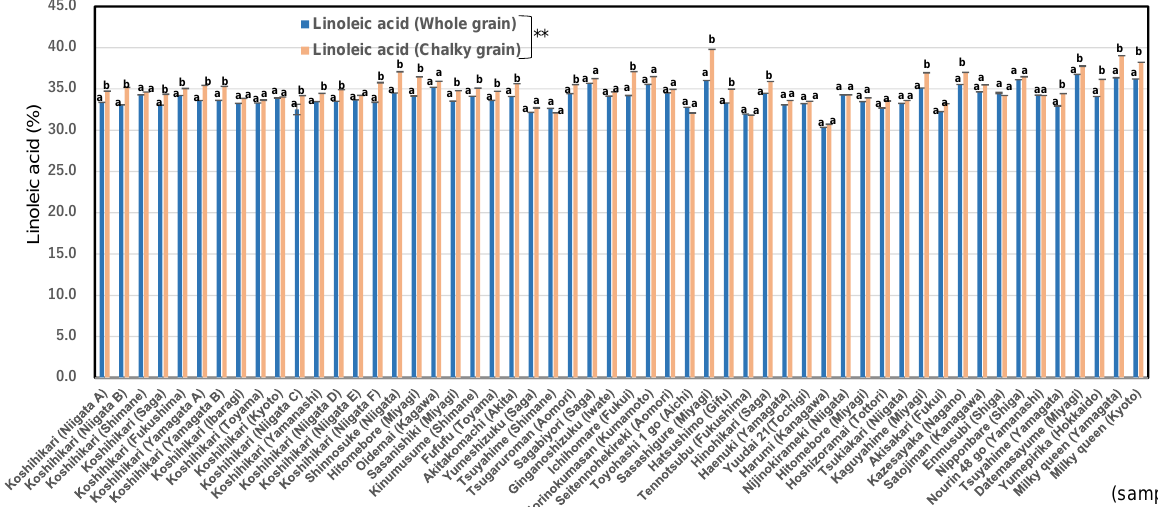
Figure 2. Comparison in linoleic acid between whole and chalky rice grains in 54 Japonica rice in 2020. Different letters (a, b) mean that whole and chalky grains in each same rice samples are significantly different. ** Correlation is significant at 1% by the method of Tukey’s multiple comparison. Formula for estimating the fatty acid content based on the pasting properties of brown rice [25].